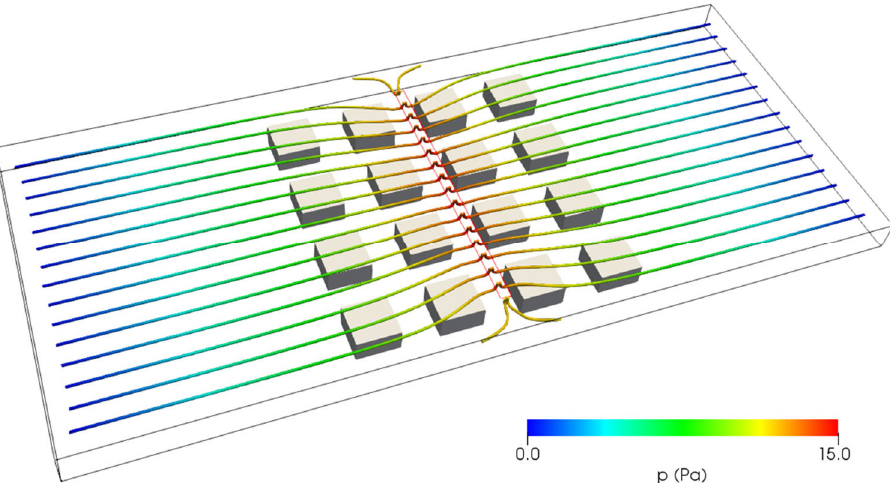
Figure 19. Predicted streamlines colored by a gauge static pressure. Reprint with permission [89]; Copyright 2021, Taylor & Francis.